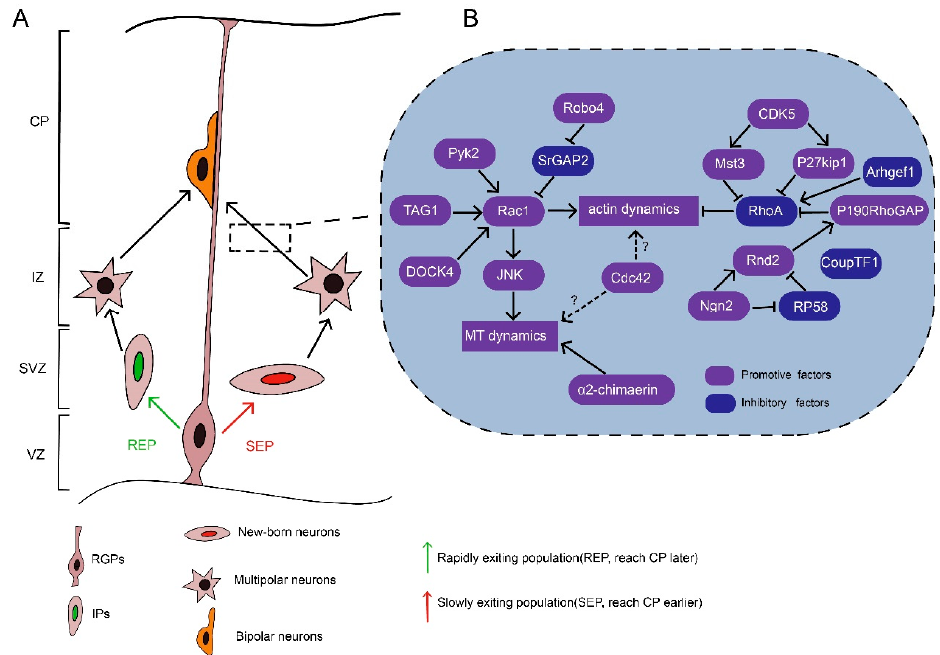
Figure 2. Rho GTPases regulate the multipolar–bipolar transition of nascent neurons. ( A ) There are two di ff erentiation modes by which RGPs become multipolar neurons, which are represented by two populations: the “rapidly exiting population” (REP, green) and the “slowly exiting population” (SEP, red). In the REP route, RGPs generate intermediate progenitors (IPs), which undergo division and di ff erentiate into neurons. In the SEP route, RGPs directly produce nascent neurons that remain in the lower part of the subventricular zone (SVZ). Both SEP and REP neurons acquire a multipolar morphology in lower intermediate zone (IZ) and take on a bipolar morphology when they reach the cortical plate (CP). ( B ) The multipolar–bipolar transition relies on actin and microtubule dynamics, which are under the precise regulation of various promotive factors (purple) and inhibitory factors (blue). Globally, the Rac1 pathway is activated to promote both actin and microtubule dynamics, while RhoA activity is inhibited by several factors. The functions of Cdc42 are still